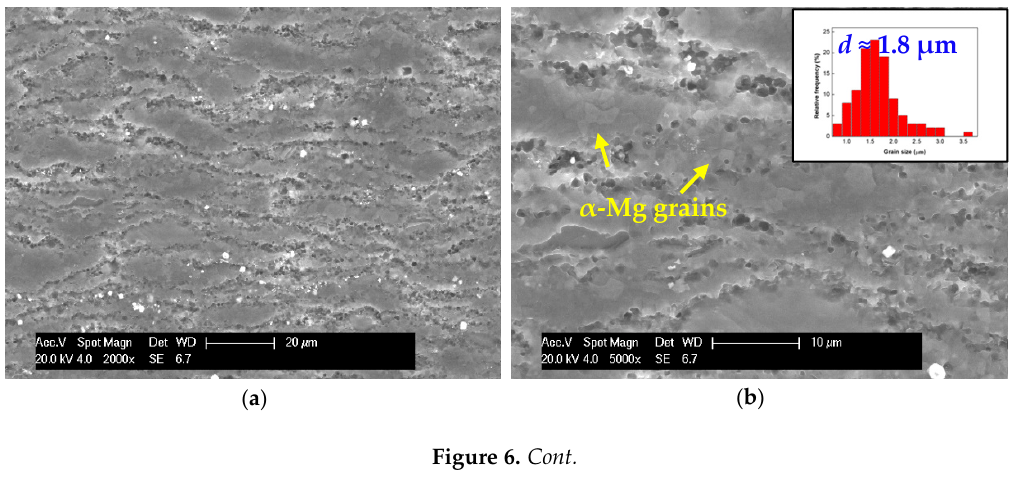
Figure 5. Age hardening curves of ECAP Mg-10Y-6Gd-1.5Zn-0.5Zr alloy for T5 and T6 heat treatments.